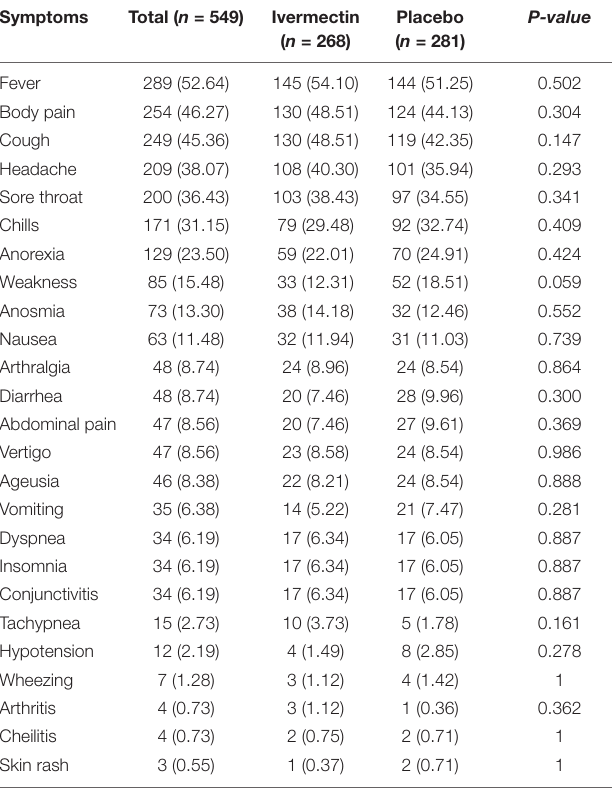
TABLE 5 | Symptoms of participants in the first visit of outpatients.